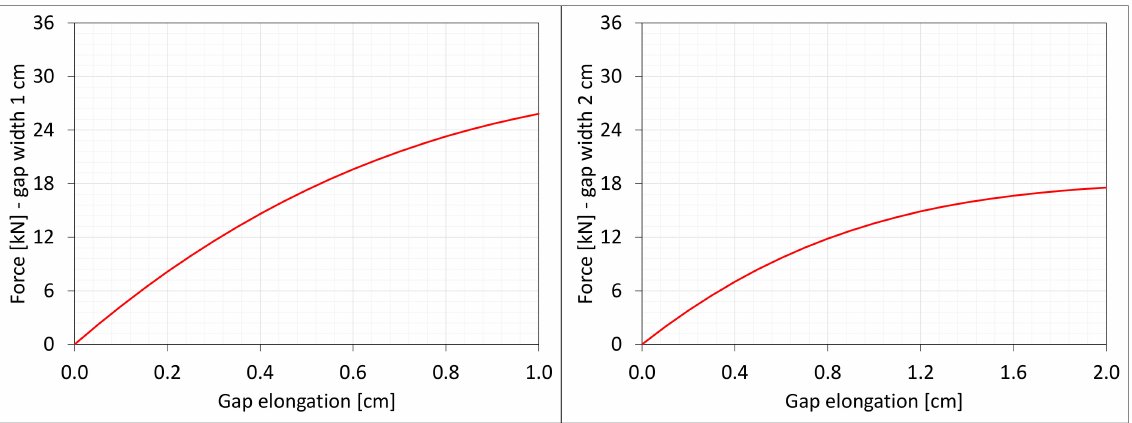
Figure 4. Equilibrium paths for excitation force σ z The width of the gap is equal to 1.0 cm, left graphic, and 2.0 cm, right